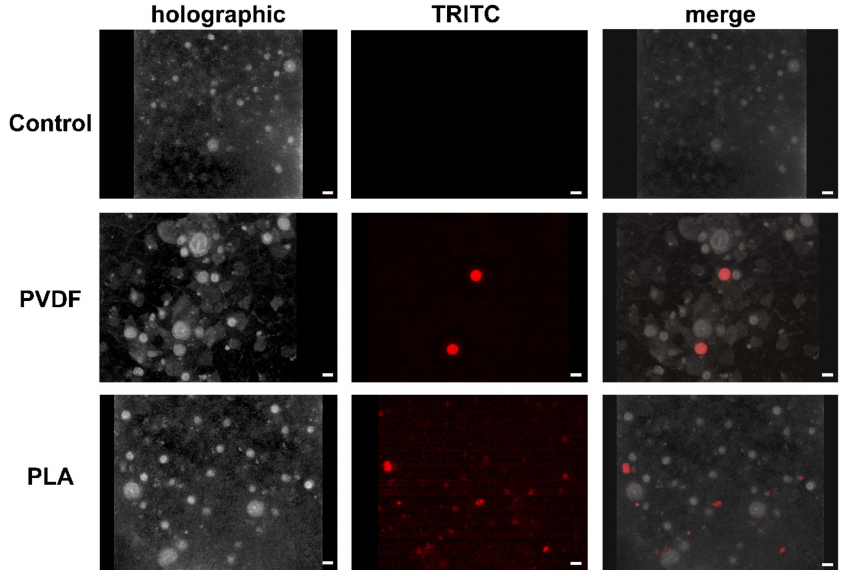
Figure 5. Epifluorescence of PVDF and PLA stained with Nile red in Aurelia sp. ephyrae jellyfish acquired together with holotomogram. Both materials (red color representing the fluorescence channel; refractive index 1.42 for PVDF and 1.4 for PLA) are localized inside the gelatinous body (index range 1.355–1.378) after 24 h exposure. Bars equal 30 µ